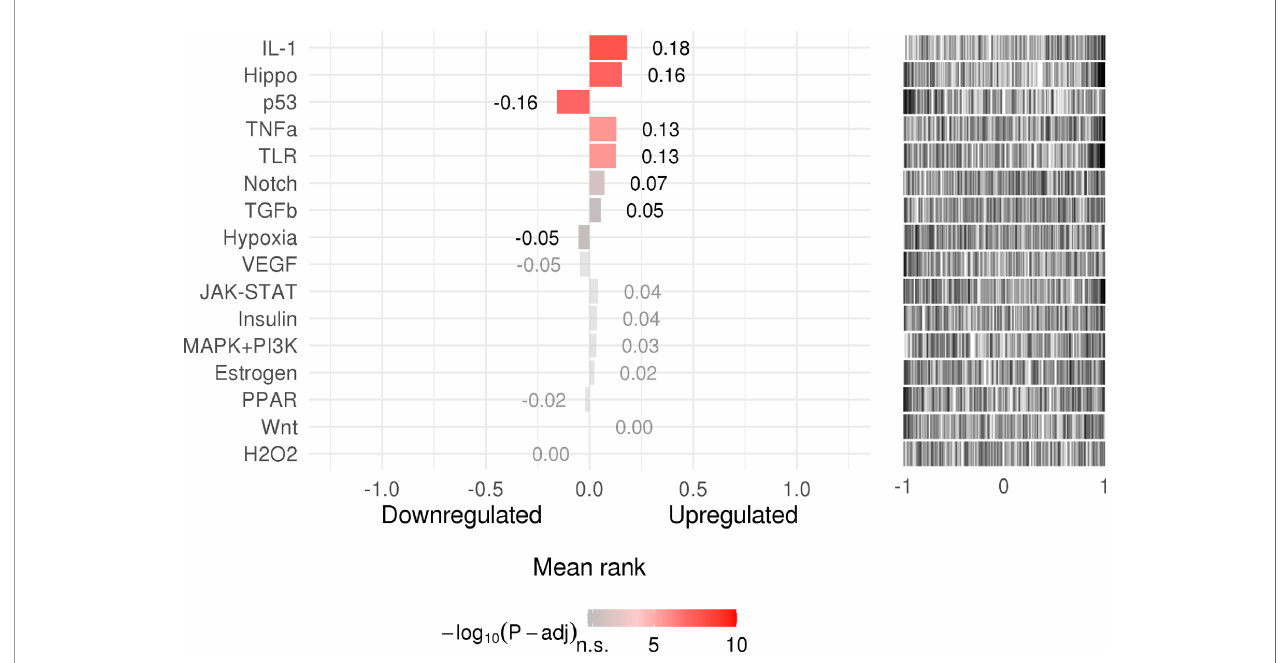
FIGURE 7 | The rank of signaling pathway activity (adjusted P-value <0.05). The color represents the adjusted P-value; the brighter the color, the higher the